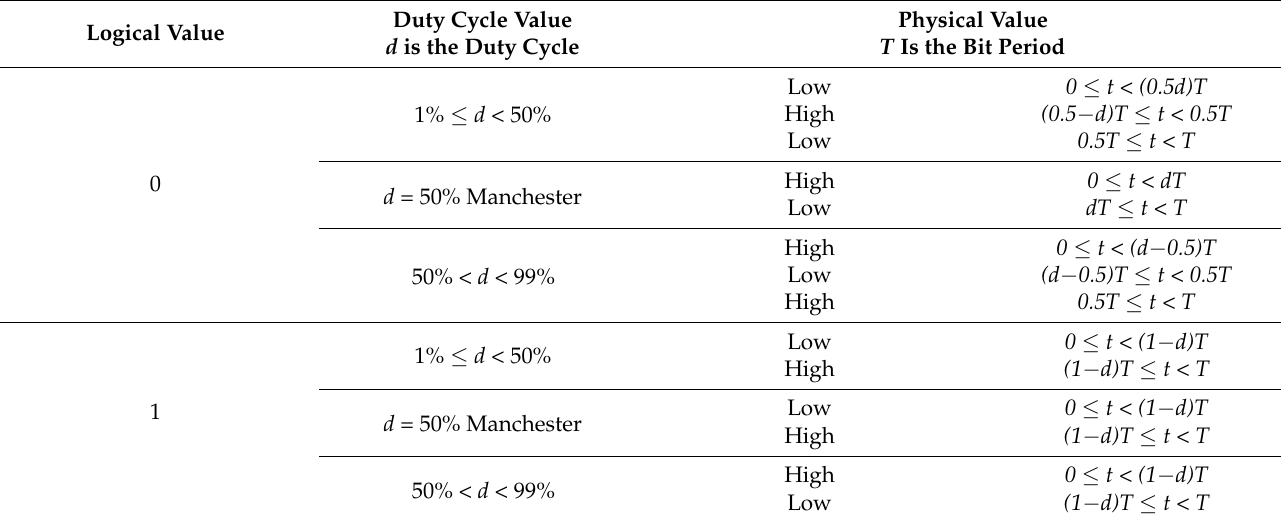
Figure 7. The scheme implemented in this work: ( a ) Average brightness less than 50%; ( b ) Average brightness equal to 50%, the same as Manchester coding; ( c ) Average brightness greater than 50%. Table 3. Definition of data mapping for the proposed code.